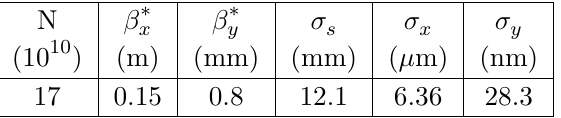
Table 1 . Parameters at the Z pole that are relevant for the determination of the beam-beam e(cid:11)ects considered here: number of particles per bunch ( N ), values of the (cid:12) function at the interaction point, in the x and y directions, bunch length including the bunch lengthening caused by beamstrahlung ( (cid:27) ), horizontal ( (cid:27) ) and vertical ( (cid:27) ) beam s x y